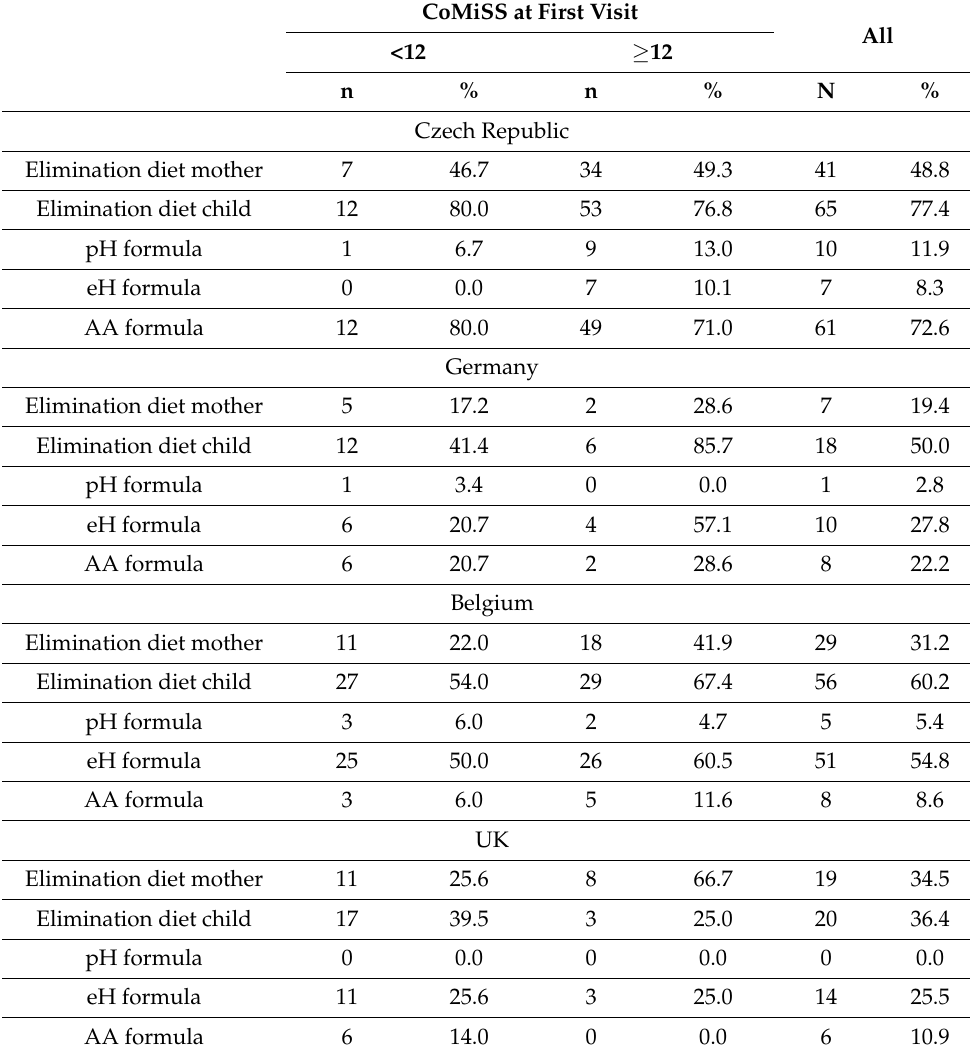
Table 9. Actions undertaken at first visit, stratified by CoMiSS at baseline, per country.